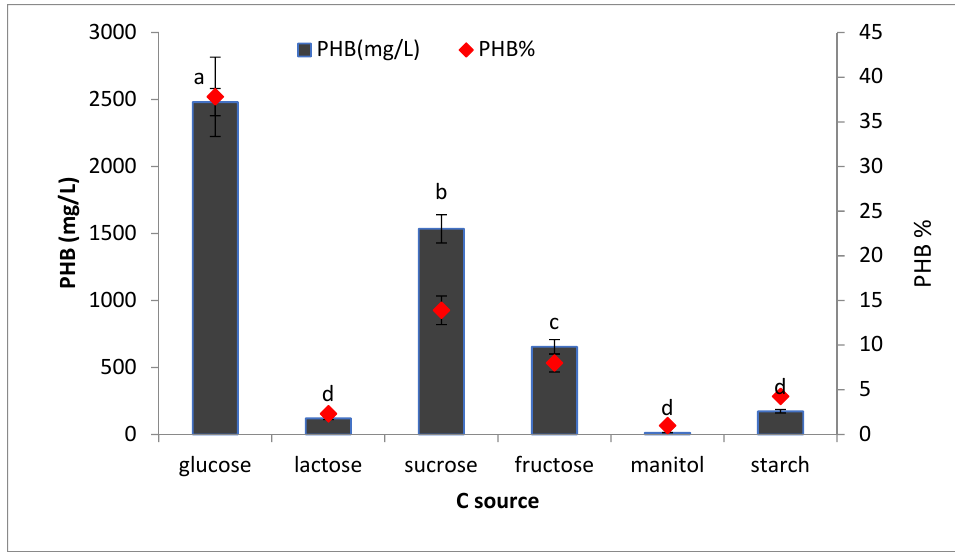
Figure 10. Effects of different C sources on the production of polyhydroxybutyrate (PHB) by Bacillus wiedmannii strain. The ANOVA test was carried out by using SPSS 21 comparisons among means ± SE standard error ( n = 3); different letters show significance at p = 0.05 level based on Duncan’s multiple range test.